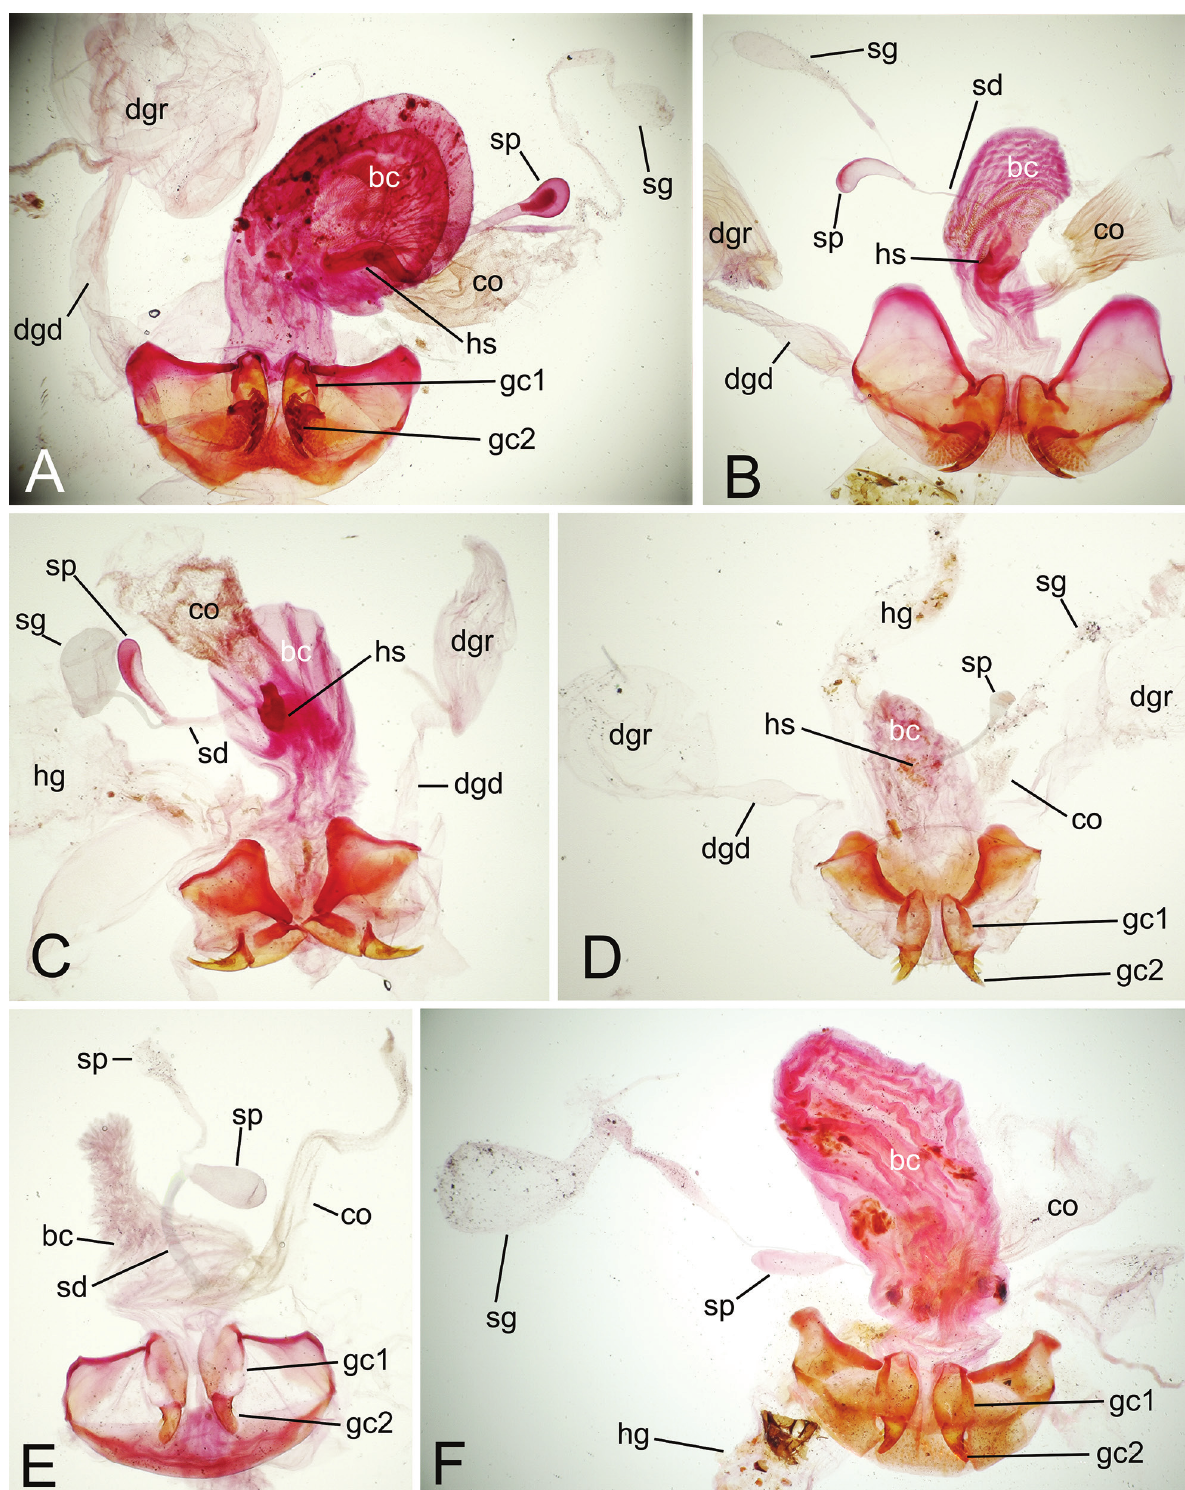
Figure 6. Female reproductive tract, gonocoxites and associated laterotergites, Amblytelus and Mecyclothorax spp: A , A. matthewsi ; B , A. brevis ; C , M. blackburni ; D , M. storeyi ; E , M. minutus ; F , M. rectangulus . See Table 2 for abbreviations.